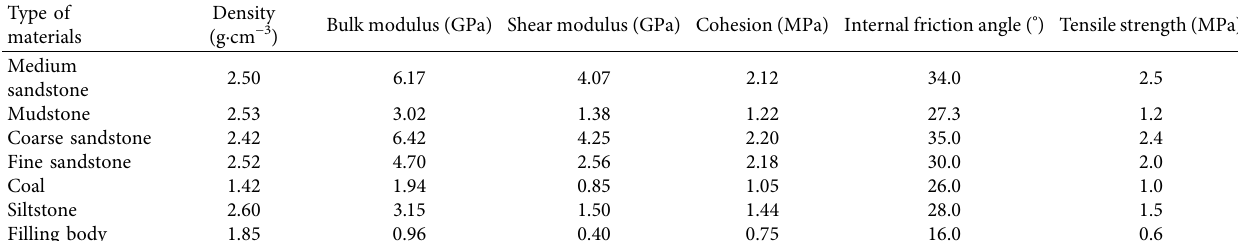
Table 1: Physical and mechanical parameters of rock mass used in the numerical model. Type of